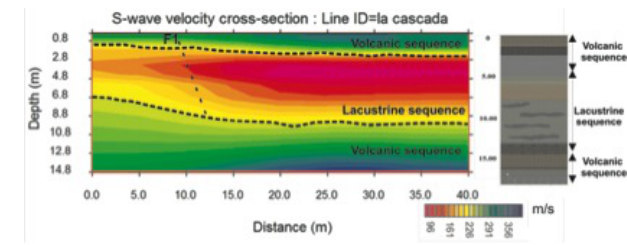
Figure 5. S-wave model, acquired from MASW method and a stratigraphic correlation with the borehole.